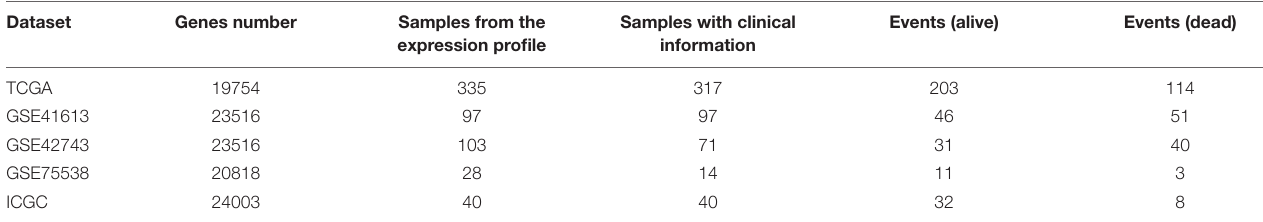
TABLE 1 | The detailed data information (i.e., genes number, sample size in the expression profile, sample size with the clinical information, and events of dead and alive, respectively) of the inferring (TCGA dataset) and cohort datasets (i.e., GSE41613, GSE42743, GSE75538, and ICGC dataset) analyzed in the current research. Dataset Genes number Samples from the expression